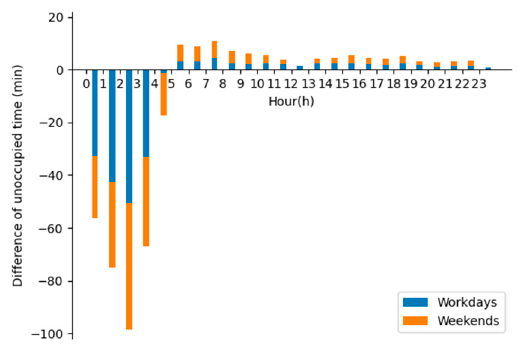
Figure 6. The relative difference between the unoccupied durations from 2015 to 2017.